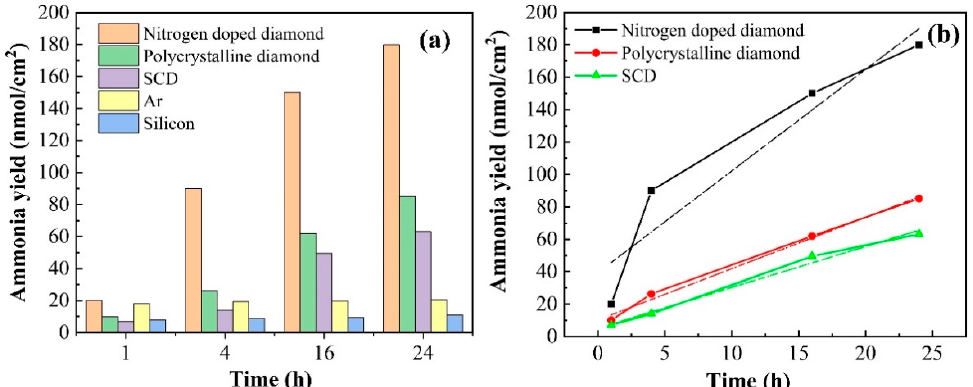
Figure 5. Catalytic efficiency of different control experiments ( a ), experimental curve and linear fit between nitrogen-doped diamond film, SCD film, and polycrystalline diamond film ( b ), the inset is fitting parameters. All of the procedures and experimental instrumentals are identical.